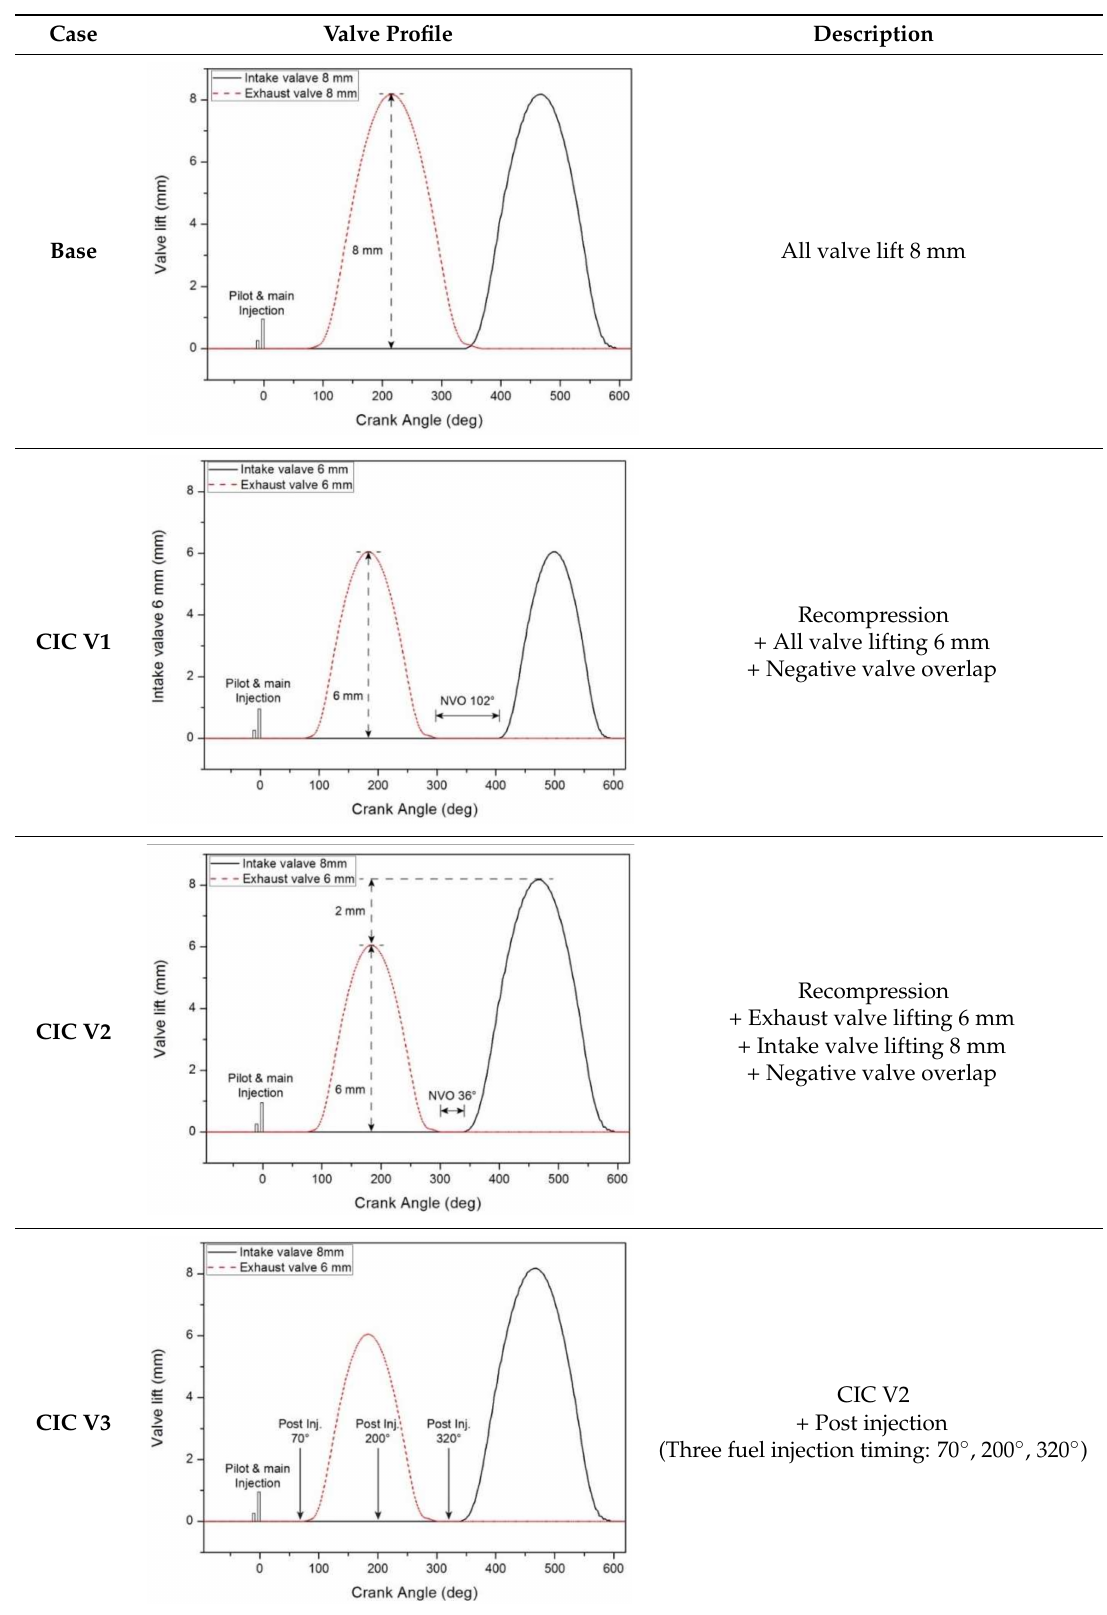
Table 3. Four variable valve train